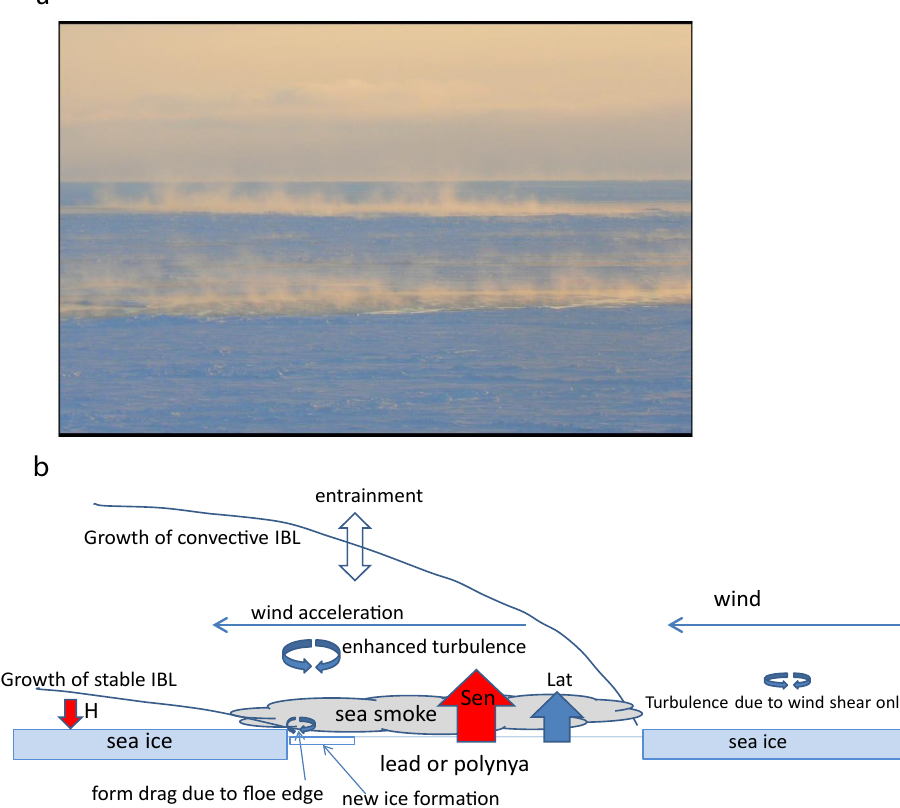
Figure 3. Convection over leads and polynyas: (a) sea smoke originating from leads in the Fram Strait on 7 March 2013 (photo: C. Lüpkes), (b) schematic presentation of ABL processes over a lead/polynya. Sen and Lat are the turbulent fluxes of sensible and latent heat,